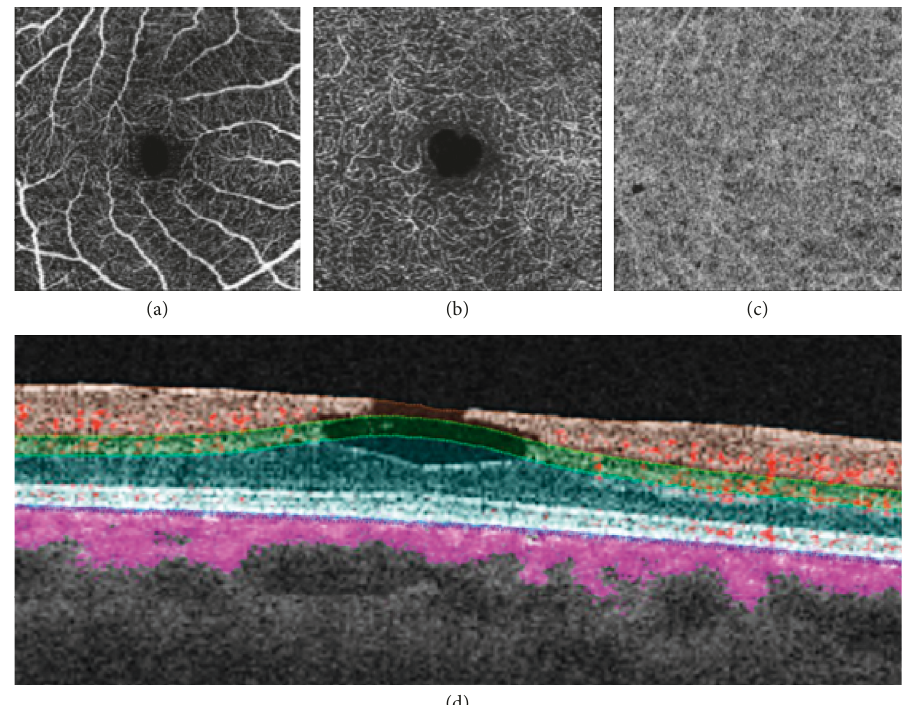
Figure 4: Optical coherence tomography (OCT) angiography in a case of degenerative lamellar macular hole. Superficial vascular plexus (top left panel) and deep vascular plexus (top middle panel) illustrate alterations of the foveal avascular zone, corresponding to the lamellar loss of inner retinal tissue. Segmentation at the level of the choriocapillaris (top right panel) demonstrates normal perfusion. The exact segmentation of the superficial vascular plexus, deep vascular plexus, and choriocapillaris (bottom panel) is illustrated on B-scan OCTwith blood flow superimposed (red flow for retinal circulation and pink flow for choroidal